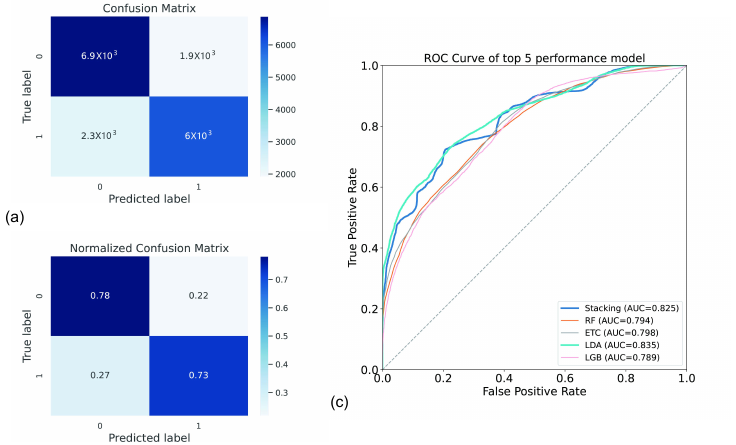
Figure 3. The confusion matrix and the ROC curve of stacking. ( a ) The confusion matrix; ( b ) the normalized confusion matrix. The performance of the model to determine whether a participant is an elderly individual at risk of frailty is displayed in the figure. ( c ) The Receiver Operating Characteristic (ROC) curve of the five best-performing models. Random Forest Classifier (RF), Extra Tree Classifier (ETC), Linear Discriminant Analysis (LDA), and LightGBM Classifier (LGB) are the abbreviations for other classification